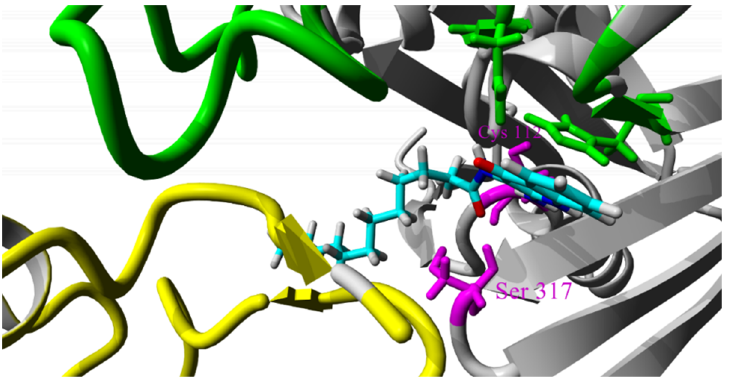
Figure 9. Docking pose of compound 4g within the active site of PqsD. Key residues for anthranilate binding of Cys112 and Ser317 are shown in magenta.